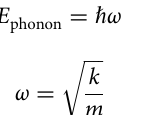
Fig. 5 Impact of LTES on Raman spectra of MoS 2 . Red shift is observed in the out-of-plane A 1g mode consistently for all three regimes of device operation — a ON state, b near-threshold region and c OFF state for stress voltage V intensity is also observed which implies that stressed MoS 2 exhibits stronger